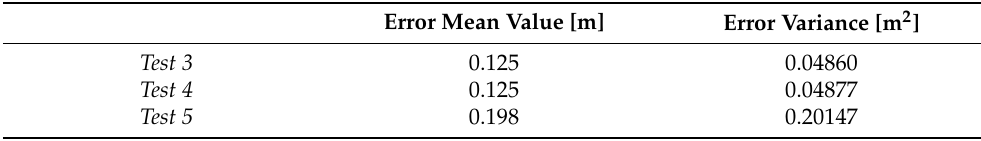
Table 5. Mean value and variance of the speed estimation error in Test 3 , Test 4 , and Test 5